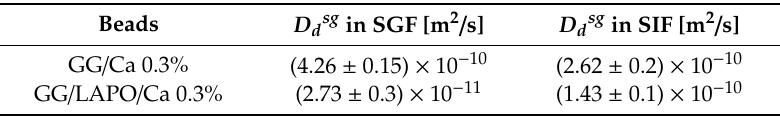
Table 4. Theophylline diffusivity in the swollen gel D dsg for two different bead formulations (with and without laponite) and two different media SGF and SIF.